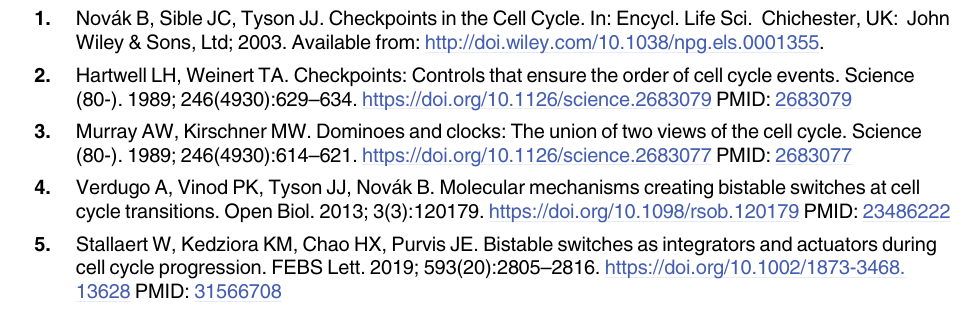
S8 Fig. Extension of the cell cycle model by additional switches. In Fig 7 in the main text we represented the cell cycle as a chain of three bistable switches. Here, we extended this model by including the hypothetical switch of FoxM1 activity with respect to CycA levels. S9 Fig. Phase locking between the circadian clock and the cell cycle. Time traces showing the absence or presence of p:q phase locking (with p and q in {1,2,3,4,5}) between the cell cycle and the circadian clock for several parameter combinations. Related to the Arnold tongues shown in Fig 8. (TIFF) S1 Video. The cell cycle can be represented as a chain of interlinked bistable switches. Video showing how the cell cycle progresses through the different bistable switches as shown in Fig 7.